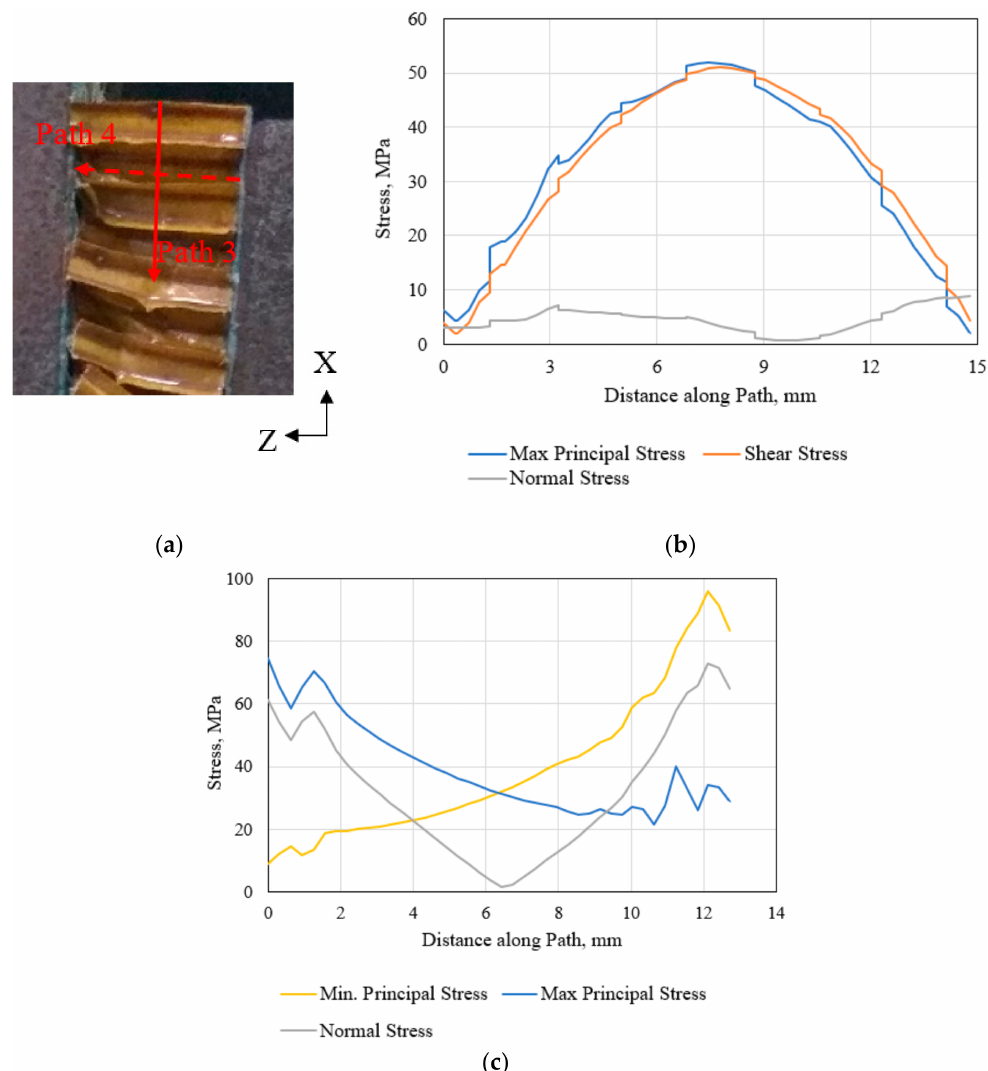
Figure 18. ( a ) Failed polymeric HC core specimen following the out-of-plane shear loading in the ribbon direction, ( b ) variation of the stresses along Path 3, and ( c ) Path 4 of the HC core model.